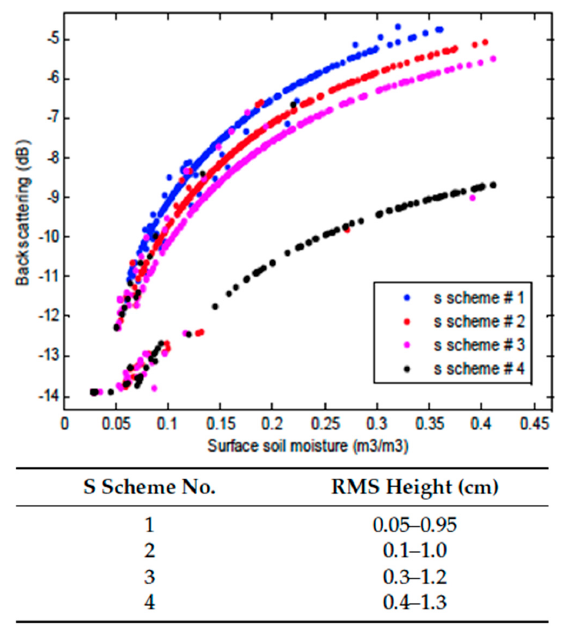
Figure 3. Nonlinear error propagation of roughness to SAR soil moisture [61]: ASAR backscattering differently retrieved soil moisture products under four roughness conditions indicated in Table. Only scheme #4 is outside of an optimal roughness range.